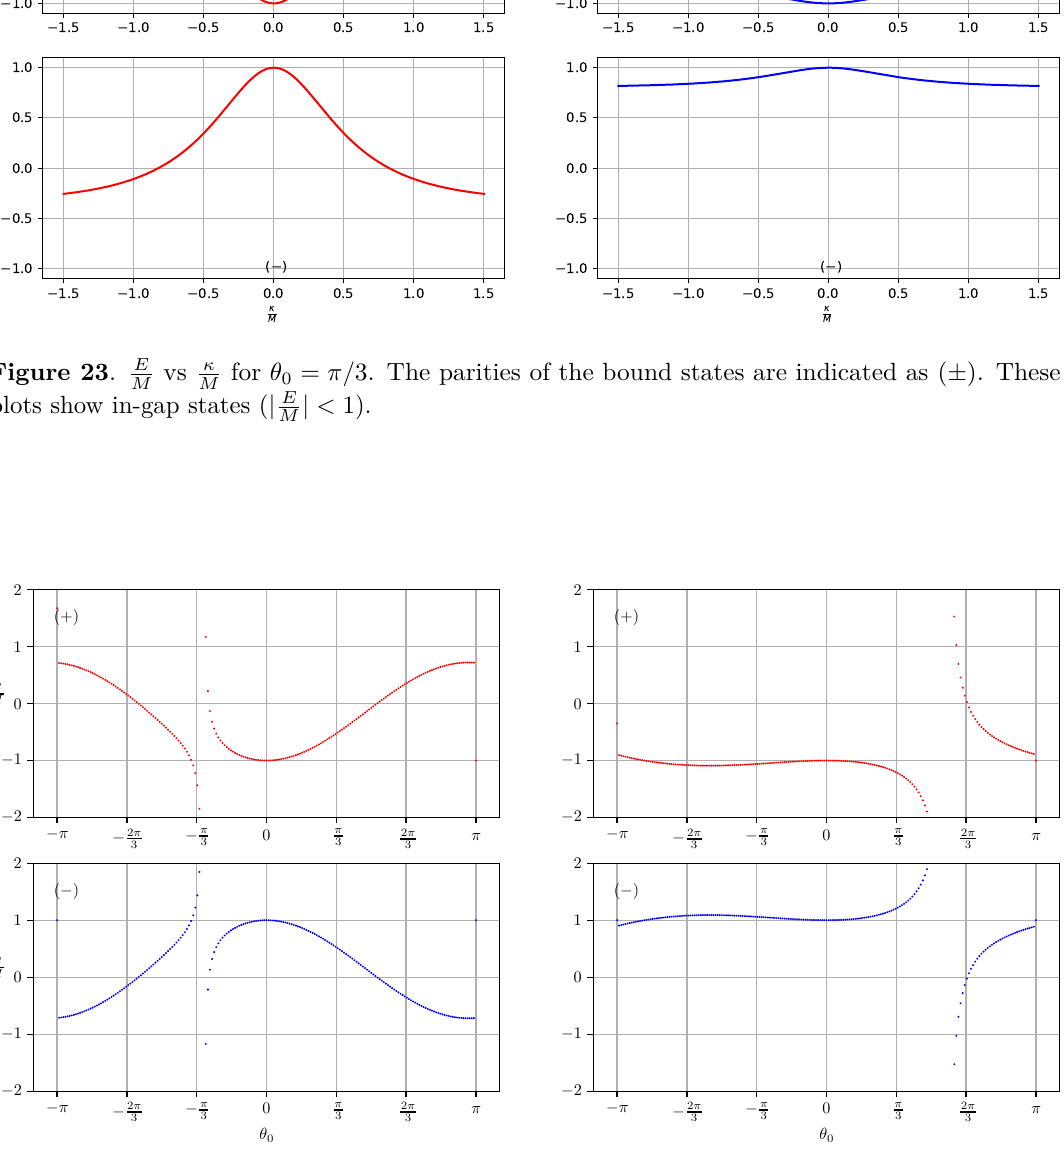
Figure 24 . E vs θ 0 . The parities of the bound states are indicated as ( ± ) . Notice the BIC states M in the both figures such that | E | > 1 for certain discrete and continuous regions of θ 0 M